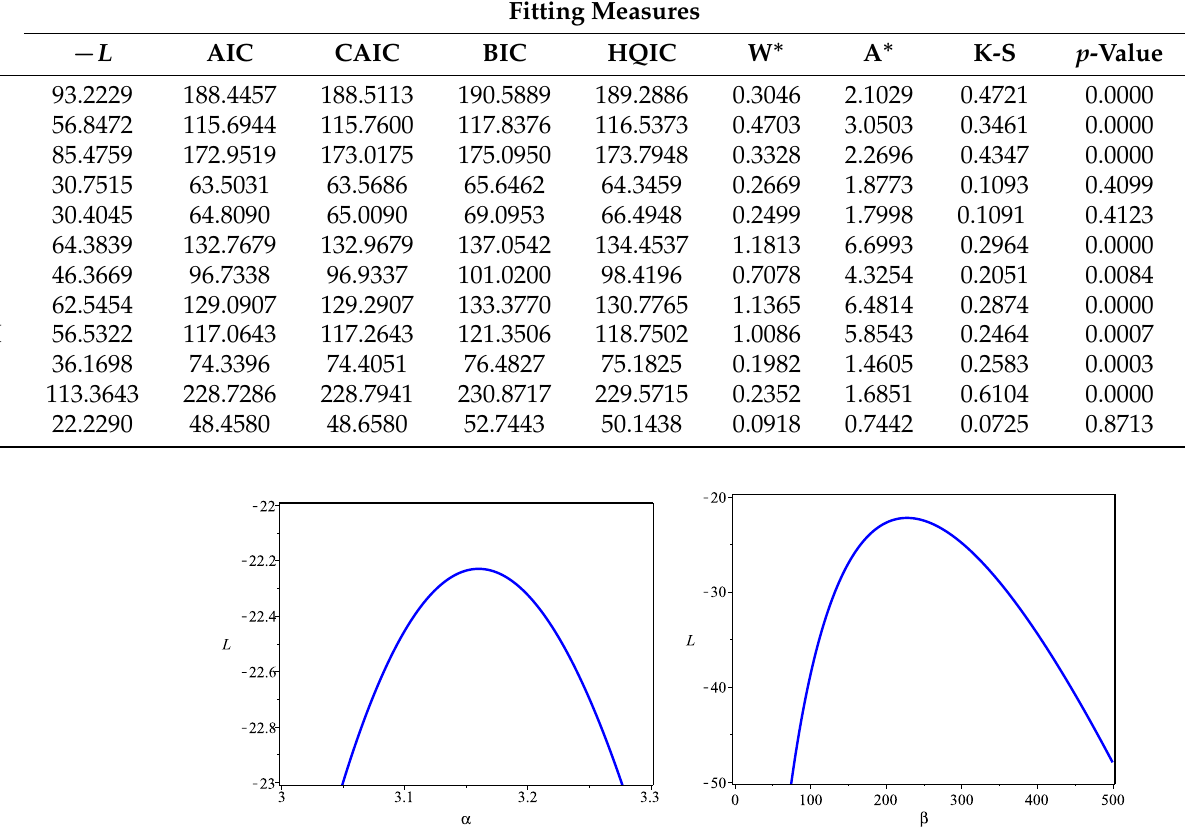
Figure 8. The profile L functions for the EBuH parameters for data set